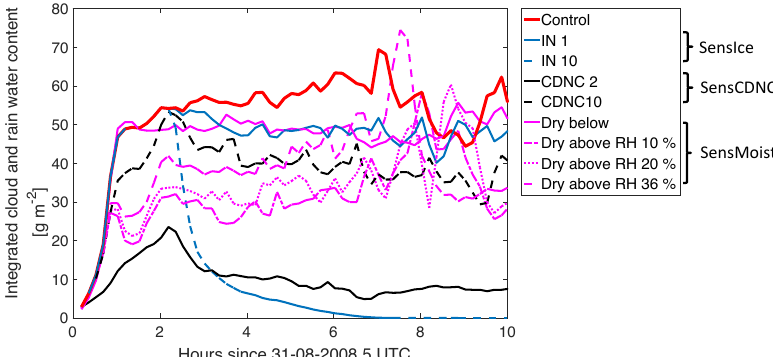
Figure 7. The domain-averaged LWP (including cloud droplets and rain) for the control simulation (red), the simulation of dry-air advection below the cloud (pink solid), the simulations of dry-air advection above the cloud top with a RH of 36% (pink dashed), a RH of 20% (pink dotted), and a RH of 10% (pink dash-dotted), the simulations with an ice crystal concentration of 1L − 1 (blue solid) and 10L − 1 (blue dashed), the simulation with a CDNC of 10cm − 3 (black dashed), and a CDNC of 2cm − 3 (black solid).